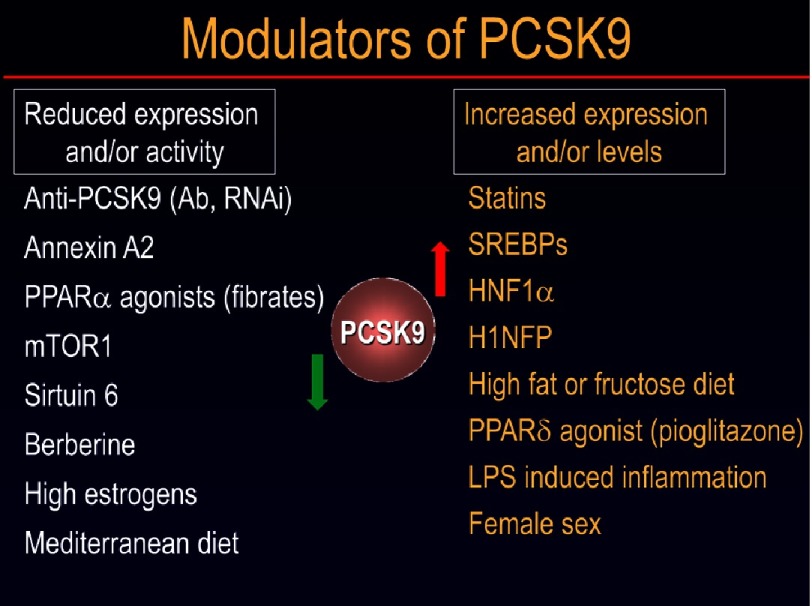
Modulators of PCSK9 function or expression.The activators are denoted with a red arrow, whereas inhibitors of PCSK9 are on the left side of the green arrow.